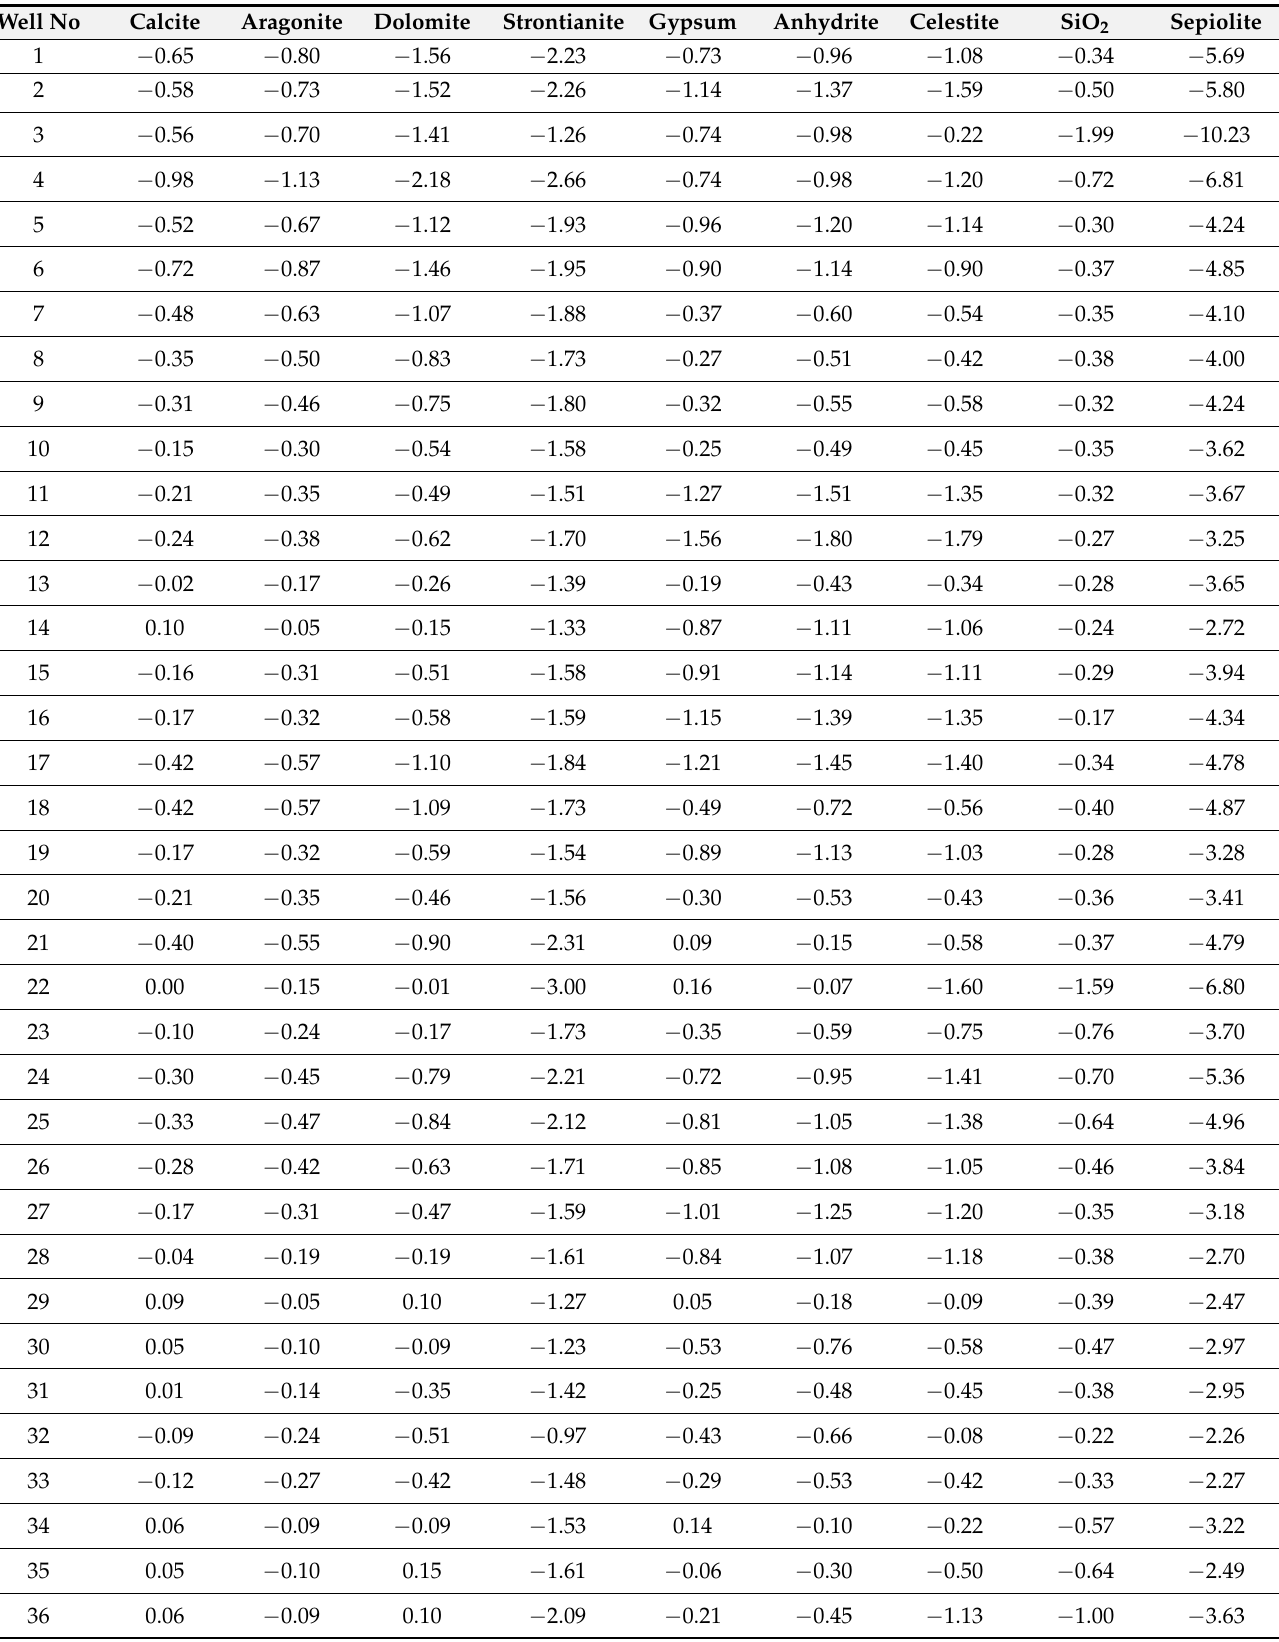
Table 1. Saturation indices values of the groundwater samples in the study